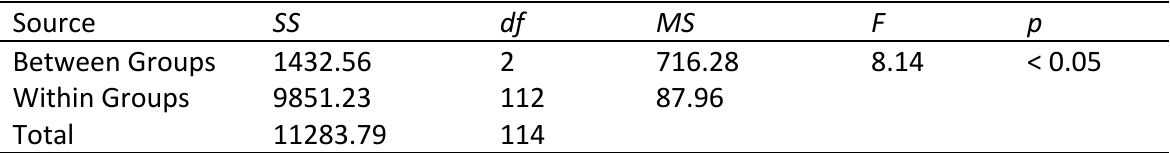
Analysis of Variance for Quality of Climate-smart Advice by Private Sector Extension, Public- Sector Extension, and both Sectors Combined (N